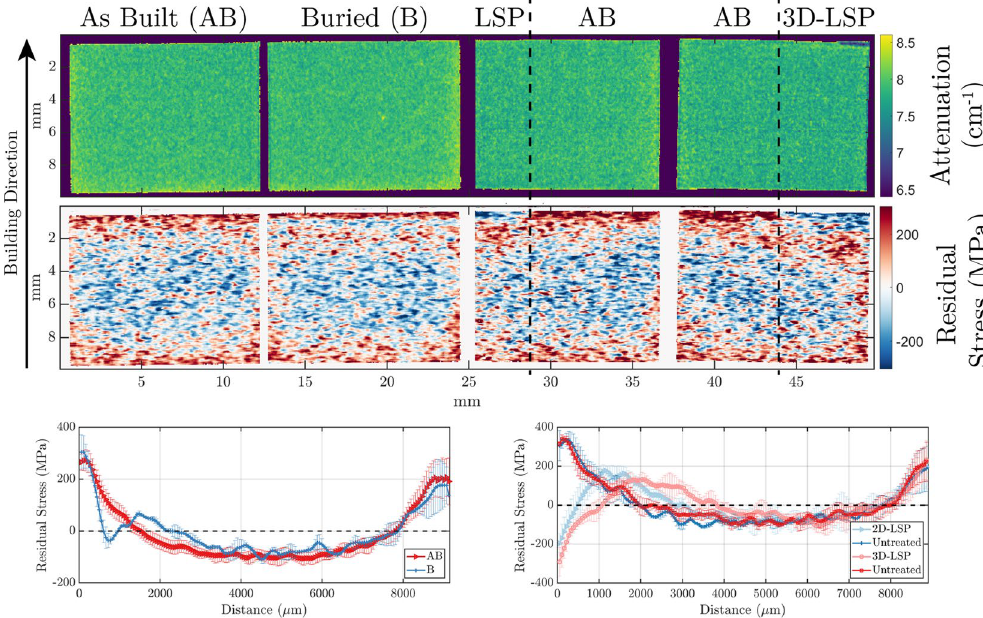
Figure 3. Top: attenuation-based contrast map of four samples exposed to different treatments. Center: the respective residual stress map. Bottom: Residual stress, measured along the build direction, of the four samples, integrated over selected regions. The RS lines corresponding to the AB and B samples were integrated over all the sample area whereas the LSP and 3D-LSP were split in two regions delimited by the black dash-dotted lines, as partial volumes of these samples were left